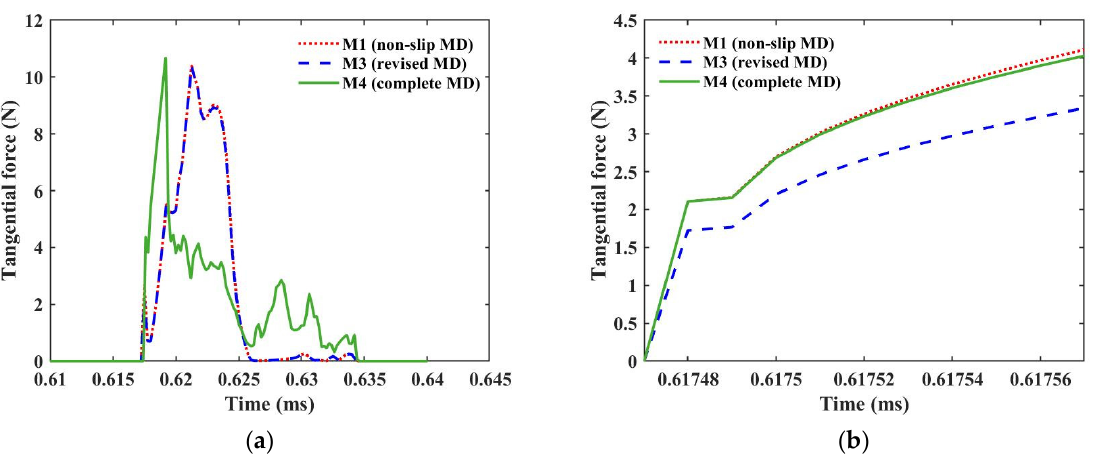
Figure 6. Comparison of the tangential forces by applying the nonlinear models. ( a ) tangential force; ( b ) static tangential force.